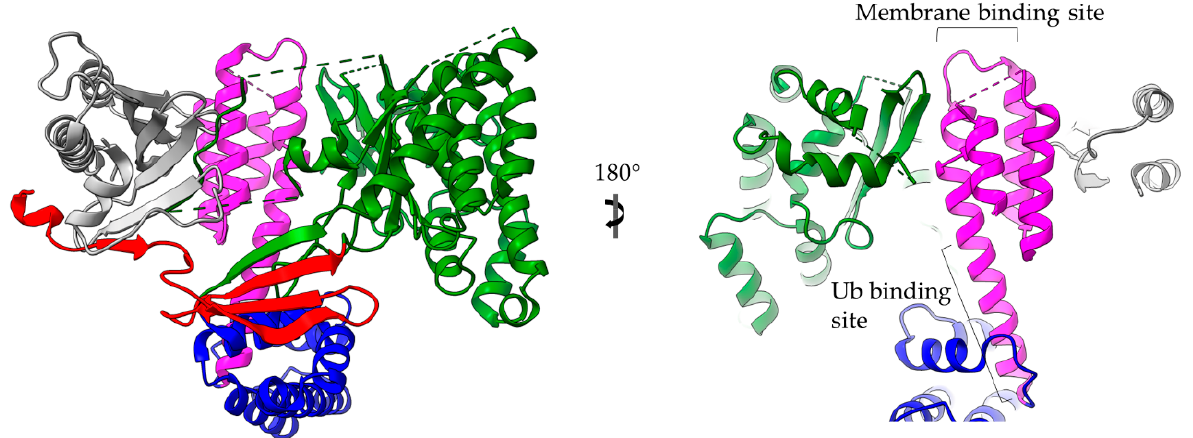
Figure 6. ExoU structure (multi-colored) in complex with the SpcU chaperone (gray). The complex is shown in two views 180 degrees apart. At the right panel the molecule has been clipped for the emphasis to be given on the 4-helix-bundle (magenta). ExoU comprises a highly unstructured N-terminal domain (red), which interacts with the chaperone, a catalytic, patatin-like domain (green), an all-helical bridging domain (blue) and a C-terminal 4-helix domain (magenta). The 4- α -helix-bundle domain is involved in the membrane and ubiquitin binding. The corresponding binding sites are indicated. Ub stands for ubiquitin.